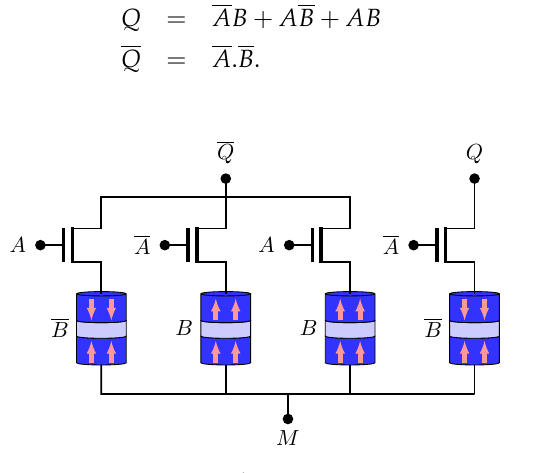
Figure 7. NV-OR / NV-NOR structure. Table 3. Truth table of OR/NOR.